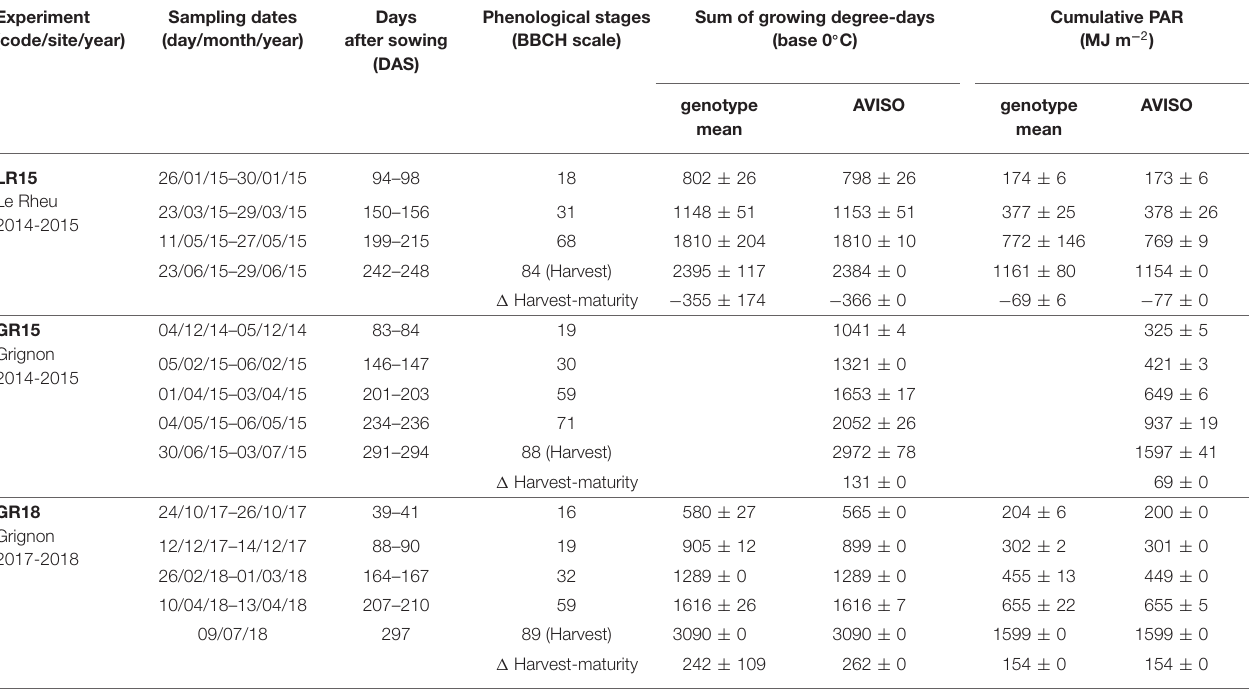
TABLE 2 | Sampling management: phenological stages and climatic conditions at each sampling date of the three experiments. Experiment